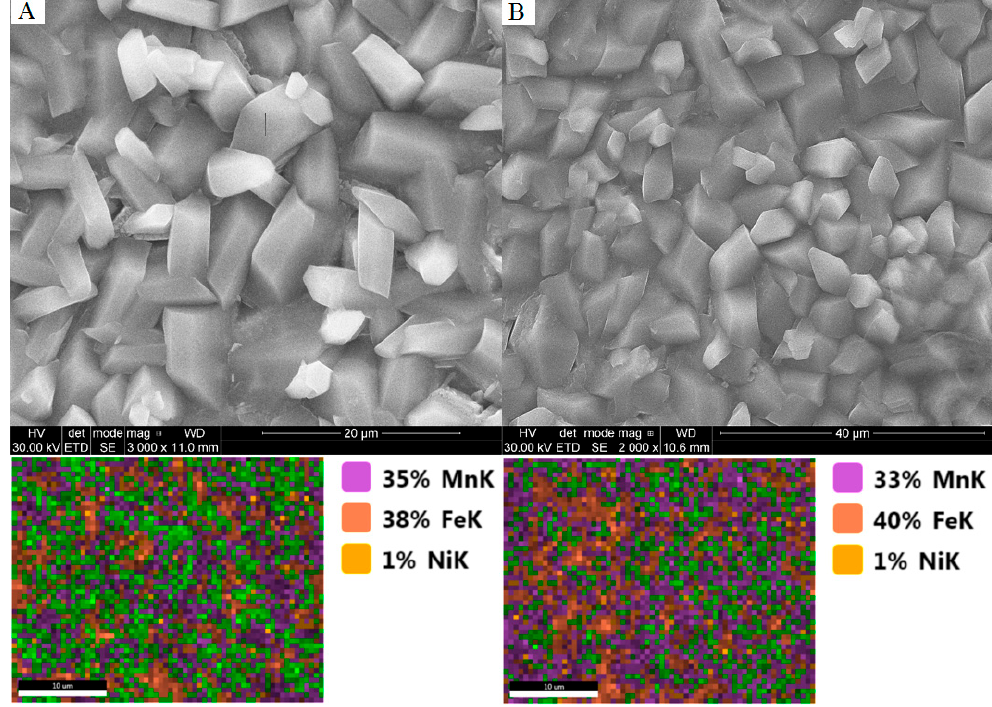
Figure 15. SEM images and EDX analysis of obtained coatings: ( A ) Without the passivation process; and ( B ) after the passivation process. and ( B ) after the passivation